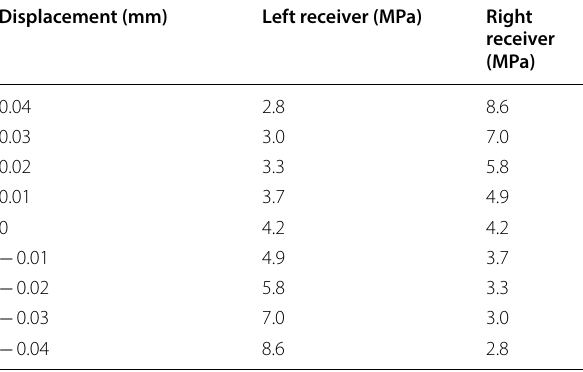
Table 2 Receiver